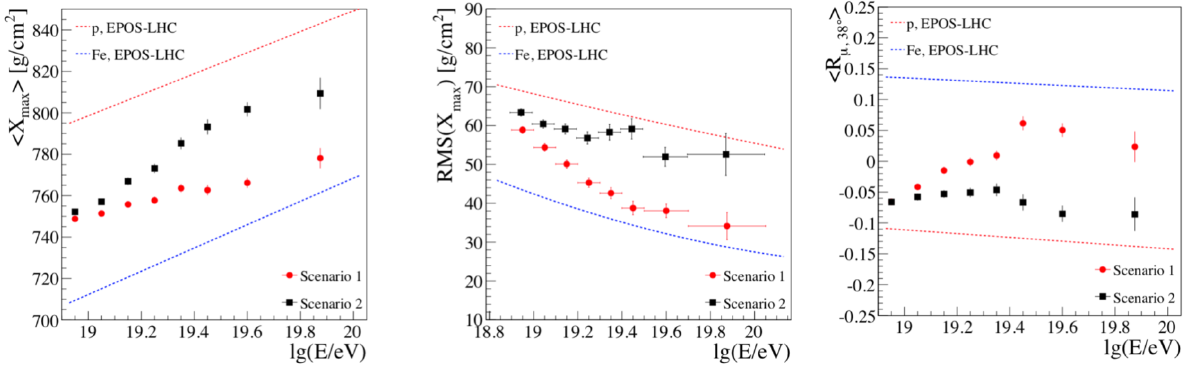
Figure 7. Mean depth of shower maximum X max (left), its fluctuations (center) and the relative muon number at 38 ◦ (right), evaluated for the two scenarios (1 = maximum rigidity model; 2 = photo-disintegration model) using simulated SD data only, for pure proton and iron compositions.